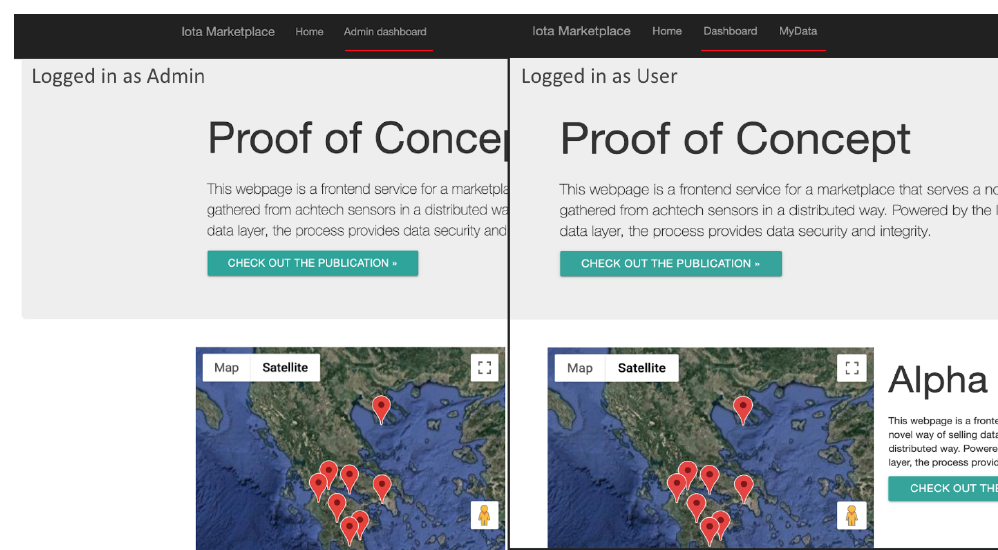
Figure 18. Edge Super Node and Cloud Subsystems.